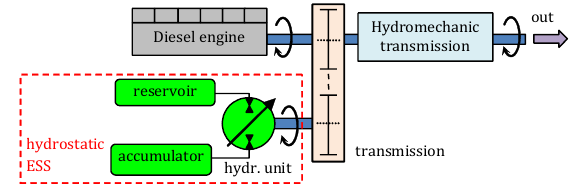
Fig. 5. A parallel hybrid drive of an internal combustion engine with a hydromechanical transmission and a hydrostatic system [17]